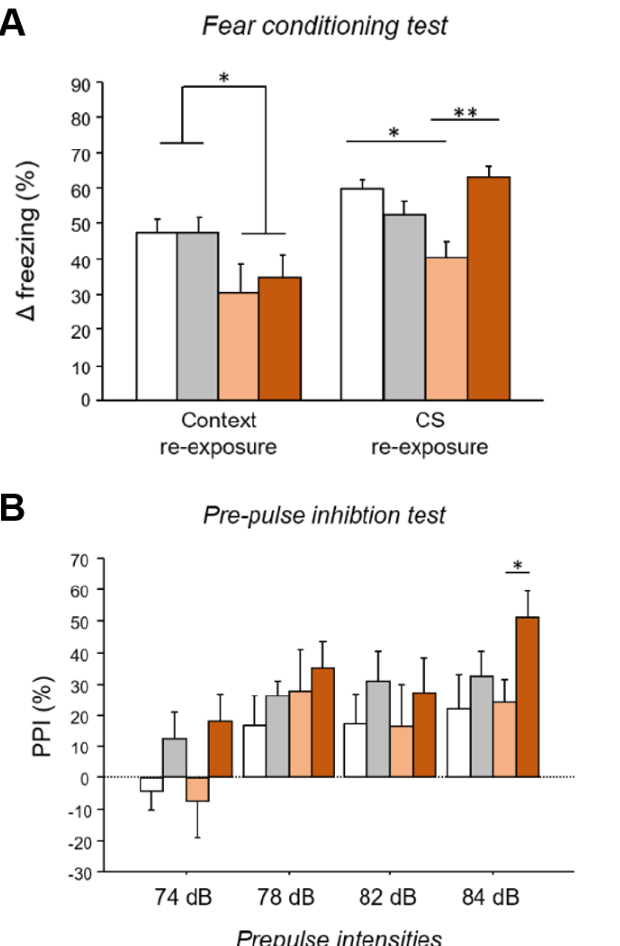
Figure 1. CNF1 treatment improves MeCP2-Bird cued fear memory deficits and increases pre-pulse inhibition in MeCP2-Bird mice. ( A ) Contextual and cued fear memory were evaluated by testing experimental mice in a fear conditioning task. The ∆ freezing was calculated as an index of fear memory and obtained by subtracting the percent time spent freezing during baseline from percent time spent freezing during either context or conditioned acoustic stimulus (CS) re-exposure.